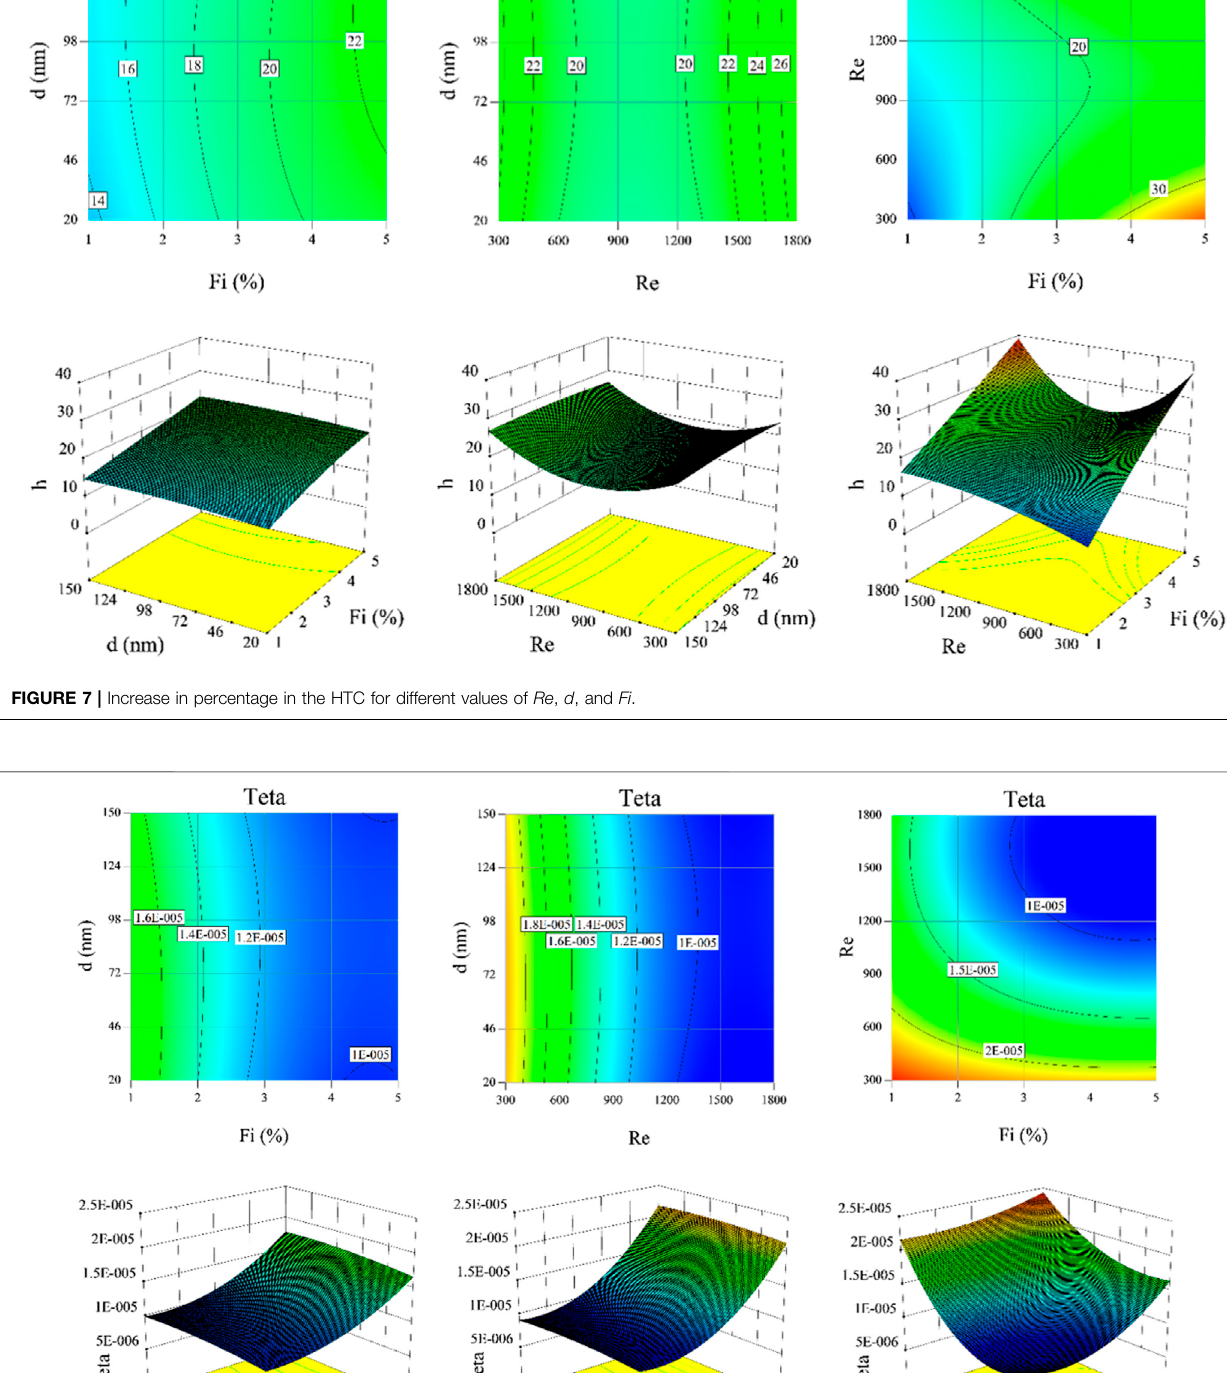
Frontiers in Energy Research |